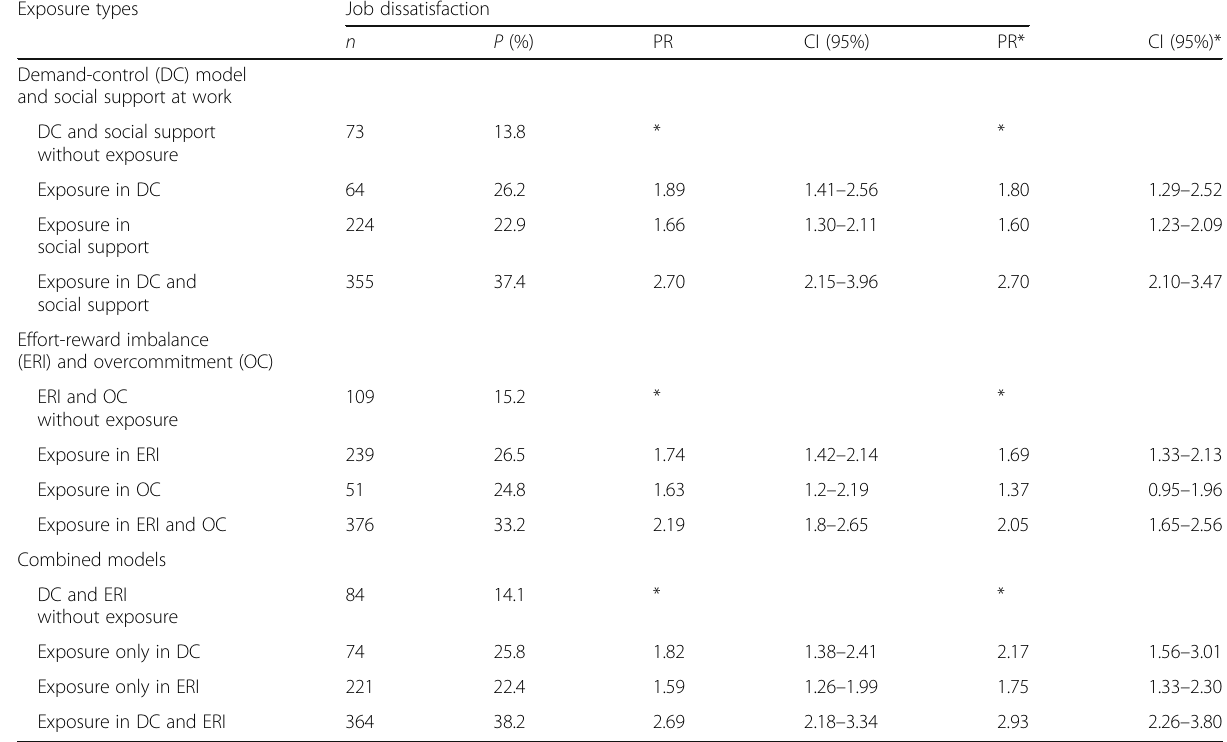
Table 5 Job dissatisfaction by partial, full, and combined occupational stress models. Health workers, Bahia, Brazil, 2012 Exposure